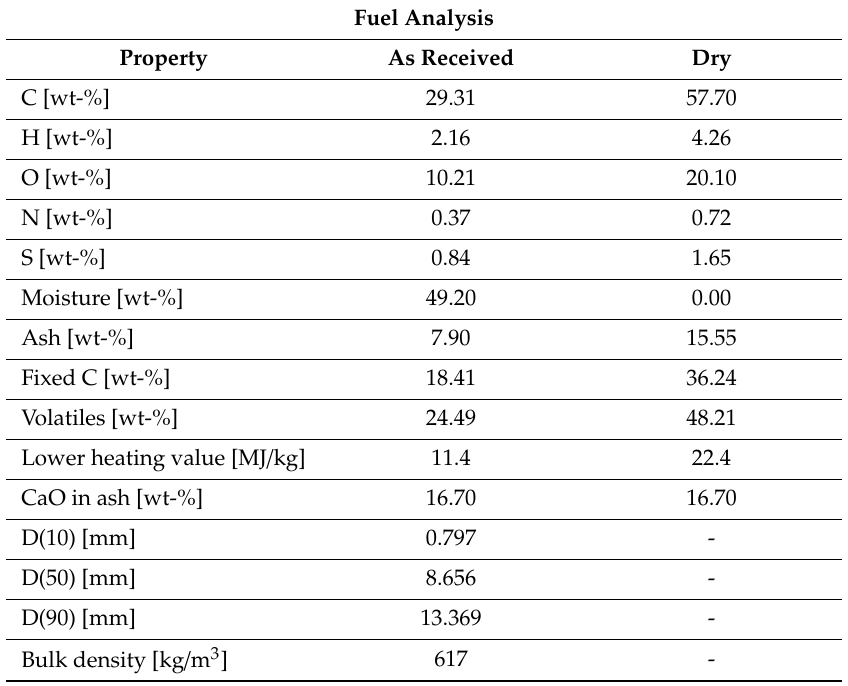
Table 3. Analyses of the polish lignite (ultimate, proximate, others).